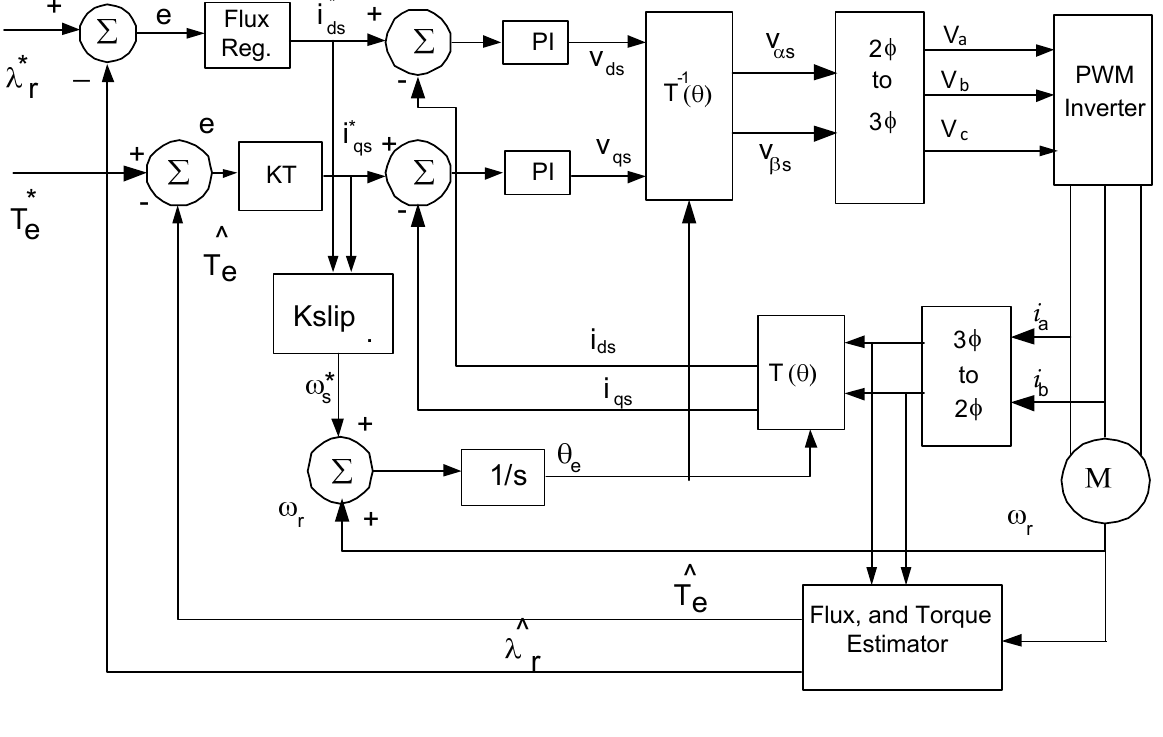
Figure 1. Indirect Field Oriented (IFO) drive system.